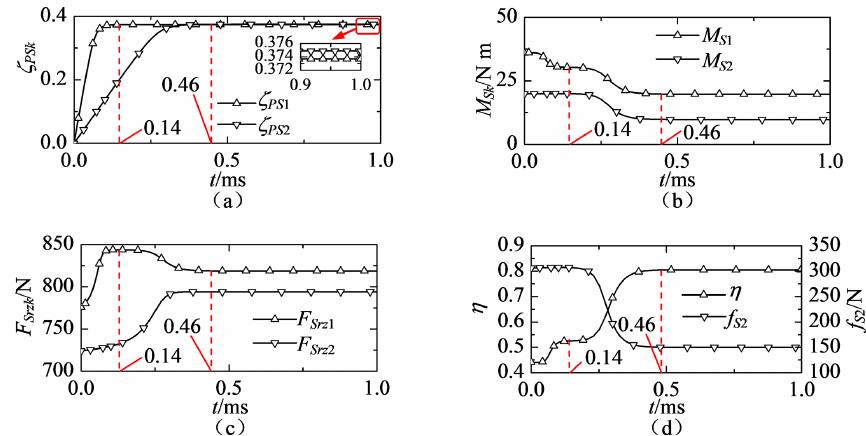
Figure 3. Transient and steady-state behaviours of the two-stage PRSM: (a) rotational velocity ratios, (b) driven torque acting on screw # k , (c) axial component of the contact force at the screw # k –roller # k interface, (d) efficiency and friction force between screw #2 and screw